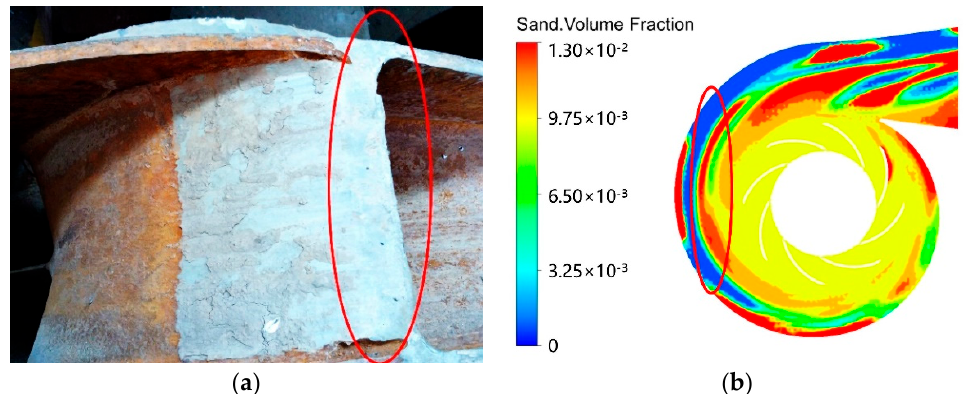
Figure 4. Physical picture of wear and cloud diagram of volume fraction of sediment particles: ( a ) physical picture of wear; ( b ) cloud diagram of volume fraction of sediment